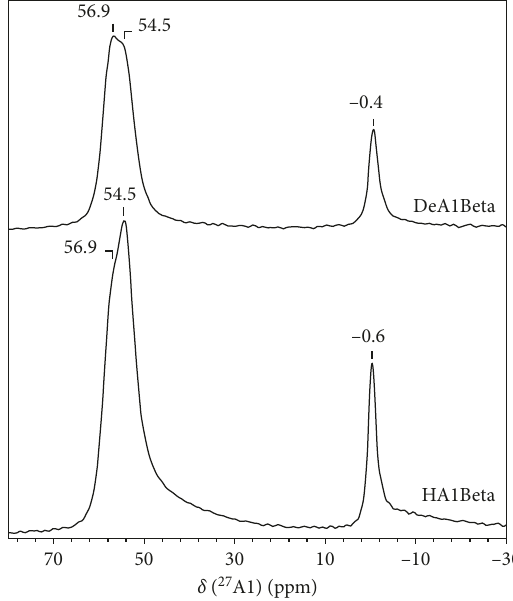
Figure 9: 27 Al MAS NMR spectra recorded at room temperature in a 4mm (the external diameter) zirconia rotor of as-prepared HAlBeta and